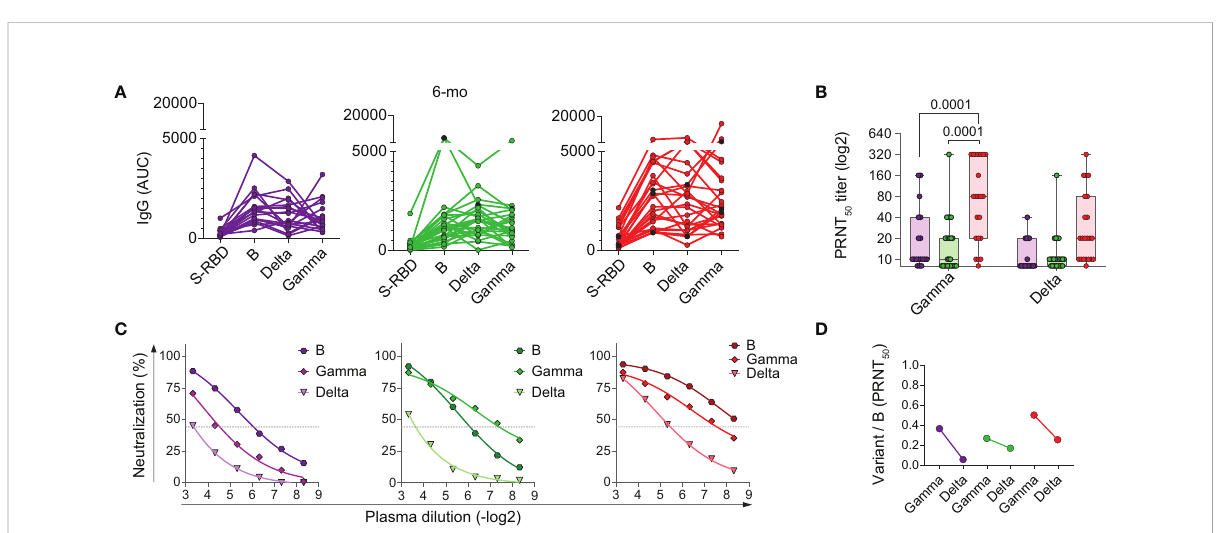
FIGURE 6 Impact of variant emergence on memory antibody recognition 6 months after acute infection. (A) Total individual IgG binding to the RBD compared to trimeric B and variants spike protein, by enzyme-linked immunosorbent assay (ELISA); (B – D) PRNT analysis and fold reduction of recognition of neutralizing antibodies. Differences between patients ’ groups were assessed by Kruskal Wallis ’ and Dunn ’ s post hoc